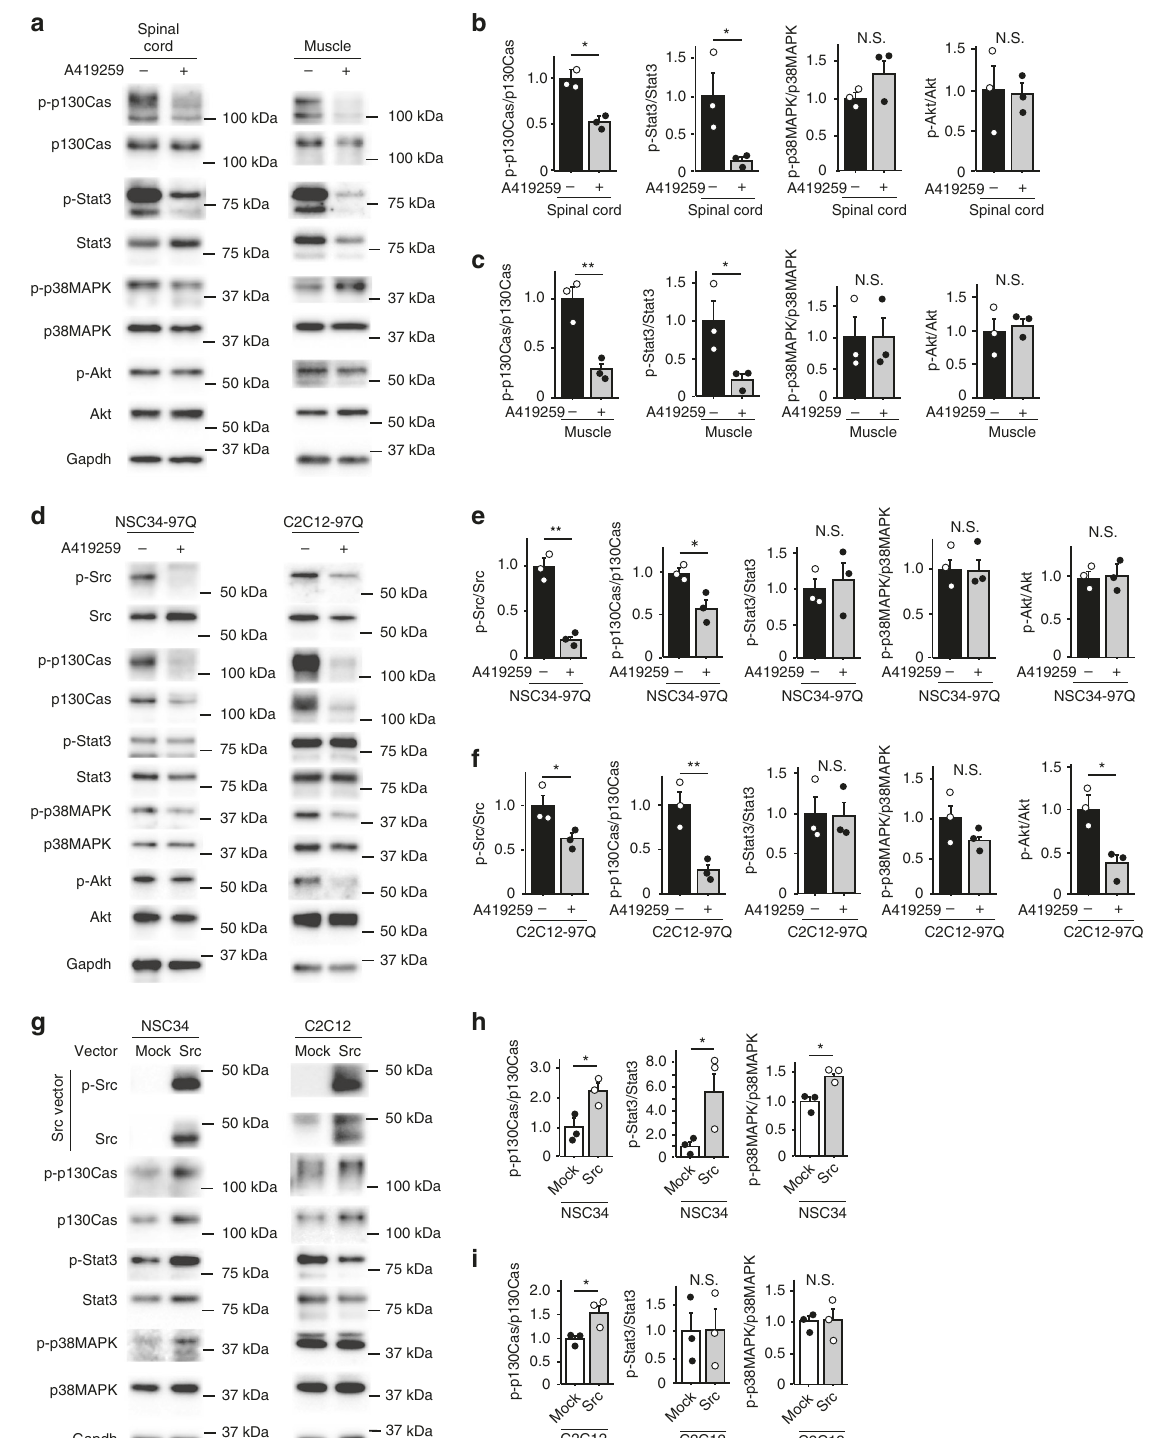
Fig. 6 Downstream targets of Src in mouse and cellular models of SBMA. a – c Immunoblots showing the levels of phosphorylated and total p130Cas, Stat3, p38MAPK, and Akt proteins in the spinal cord and skeletal muscle of 9-week-old AR-97Q mice treated with or without A419259 ( a ). Quantitative analyses were performed using densitometry ( b , c ). d – f Immunoblots showing the levels of the phosphorylated and total Src, p130Cas, Stat3, p38MAPK, and Akt proteins in DHT-treated NSC34 and C2C12 cells stably expressing AR-97Q with or without 0.2 µ M of A419259 administration ( d ). Quantitative analyses were performed using densitometry ( e , f ). g – i Immunoblots showing the levels of the phosphorylated and total Src, p130Cas, Stat3, and p38MAPK proteins in the NSC34 and C2C12 cells transfected with mock or Src plasmids ( g ). Quantitative analyses were performed using densitometry ( h , i ). Quantitative analyses were performed on samples from n = 3 animals per group. Error bars indicate the s.e.m. Statistical analyses were performed using the unpaired two-sided t -test ( b , c , e , f , h , i ). * p < 0.05 and ** p < 0.01. N.S., not signi fi cant. Source data are provided as a Source Data fi le ( a – i